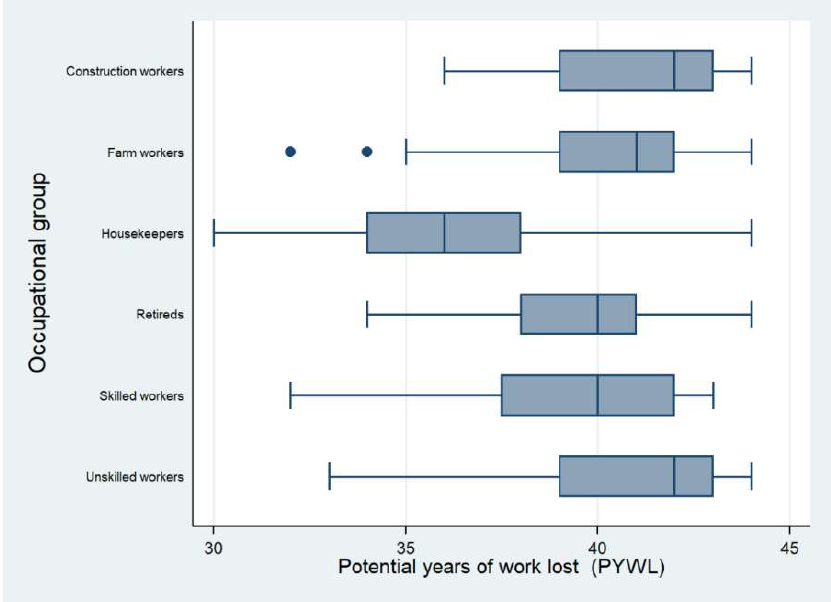
Figure 2. Potential Years of Work Lost (PYWL) by occupation.